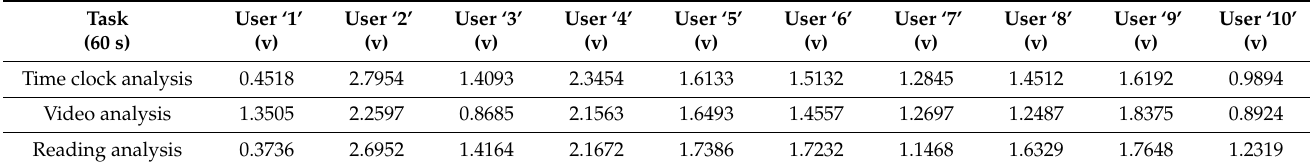
Table 2. Stress analysis of three distinct